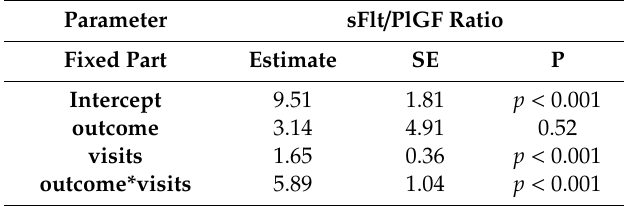
Figure 1. Longitudinal changes of soluble FMS-like Tyrosine Kinase 1 (sFlt-1) / placental growth factor (PlGF) ratio during pregnancy in women with adverse obstetric outcome compared to women with normal pregnancies. Table 3. Longitudinal changes of sFlt-1 / PlGF ratio during pregnancy.